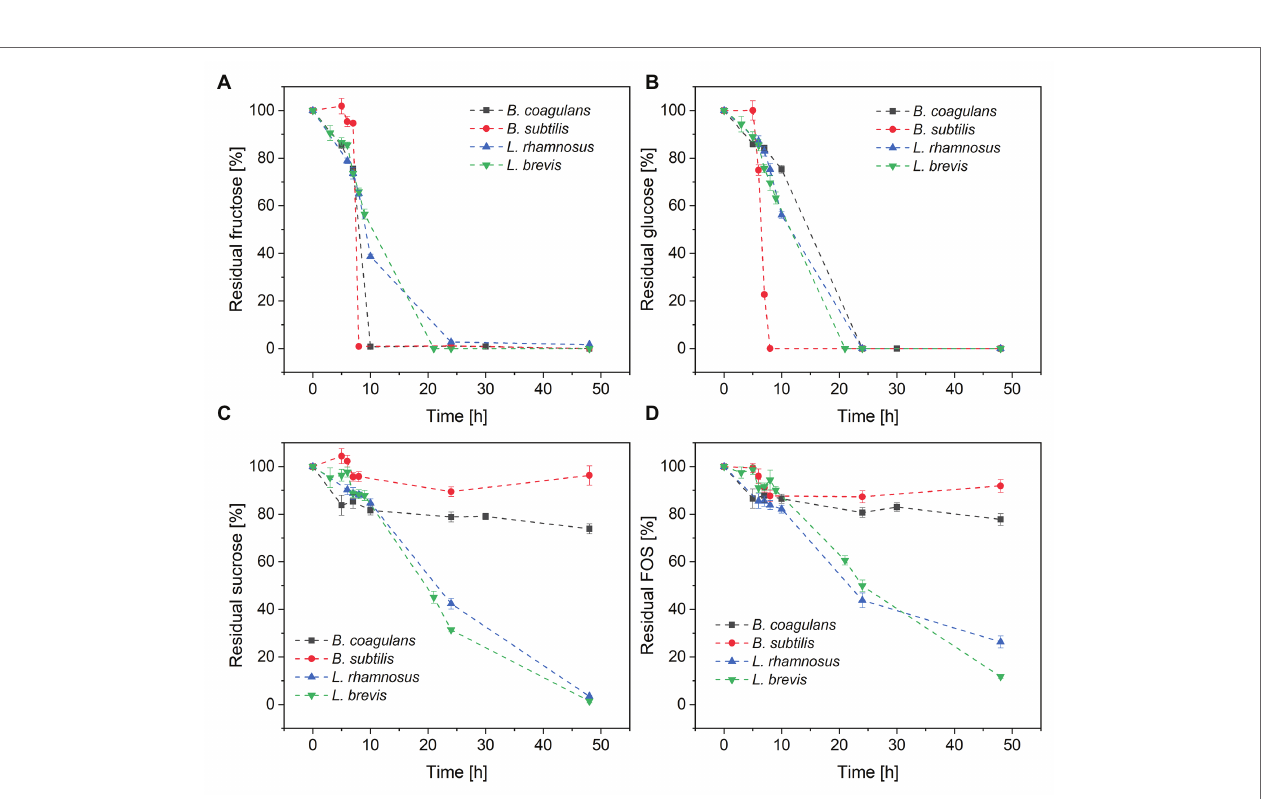
FIGURE 2 | Morphology of probiotic bacteria after 48 h during the fermentation of crude FOS. T = 40 ° C, pH = 6.8, and agitation = 0.5 vvm. Arrows indicate the typical morphology of bacillus endospores.